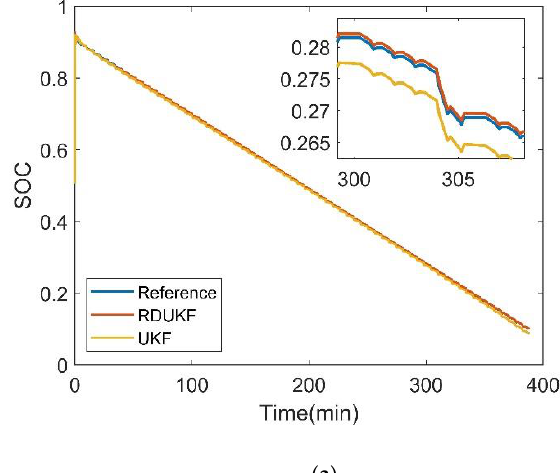
Table 2. Estimated error under the DST.